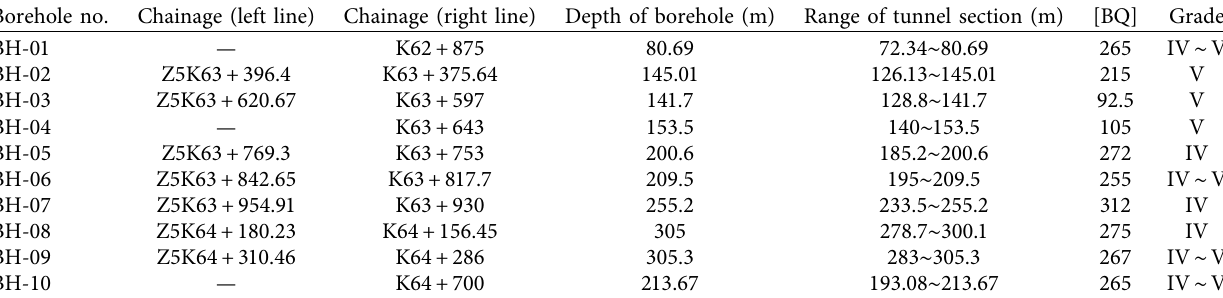
Table 1: Detailed information of